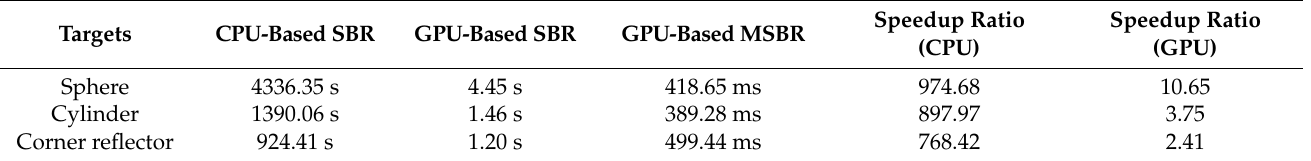
Table 4. The comparison of average runtime per angle of three targets at 15